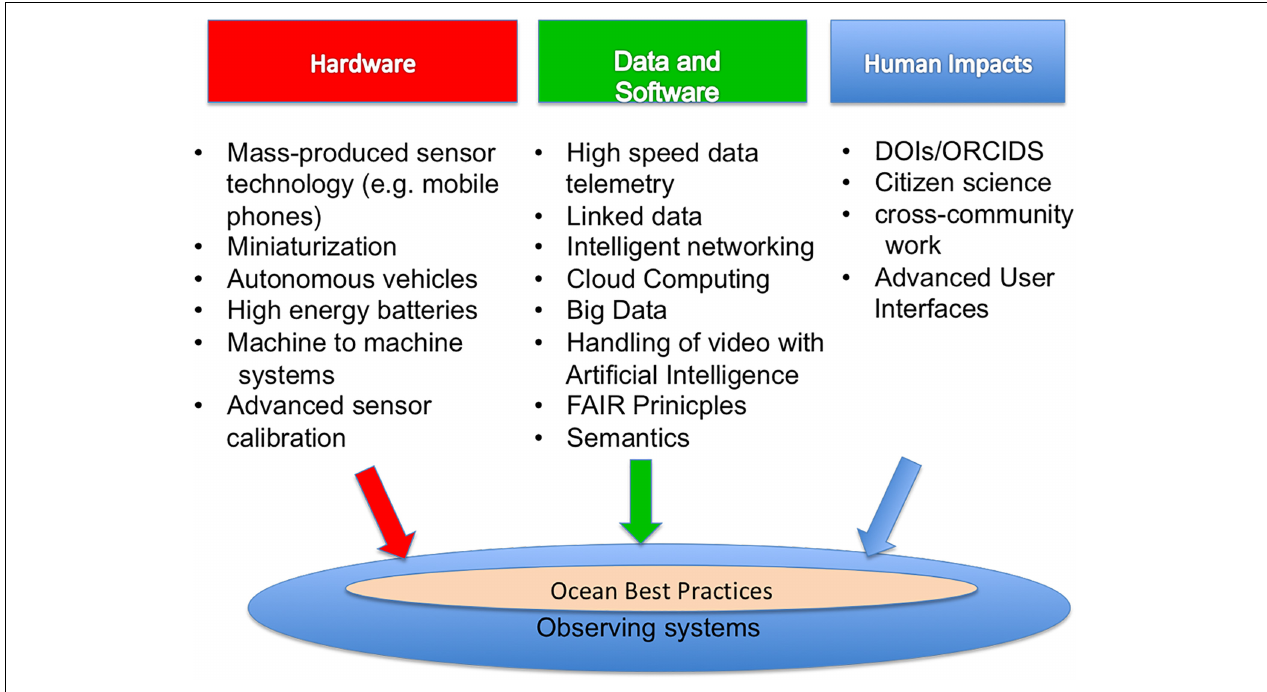
FIGURE 4 | Advances in the next decade will enhance ocean observing and impact best practices